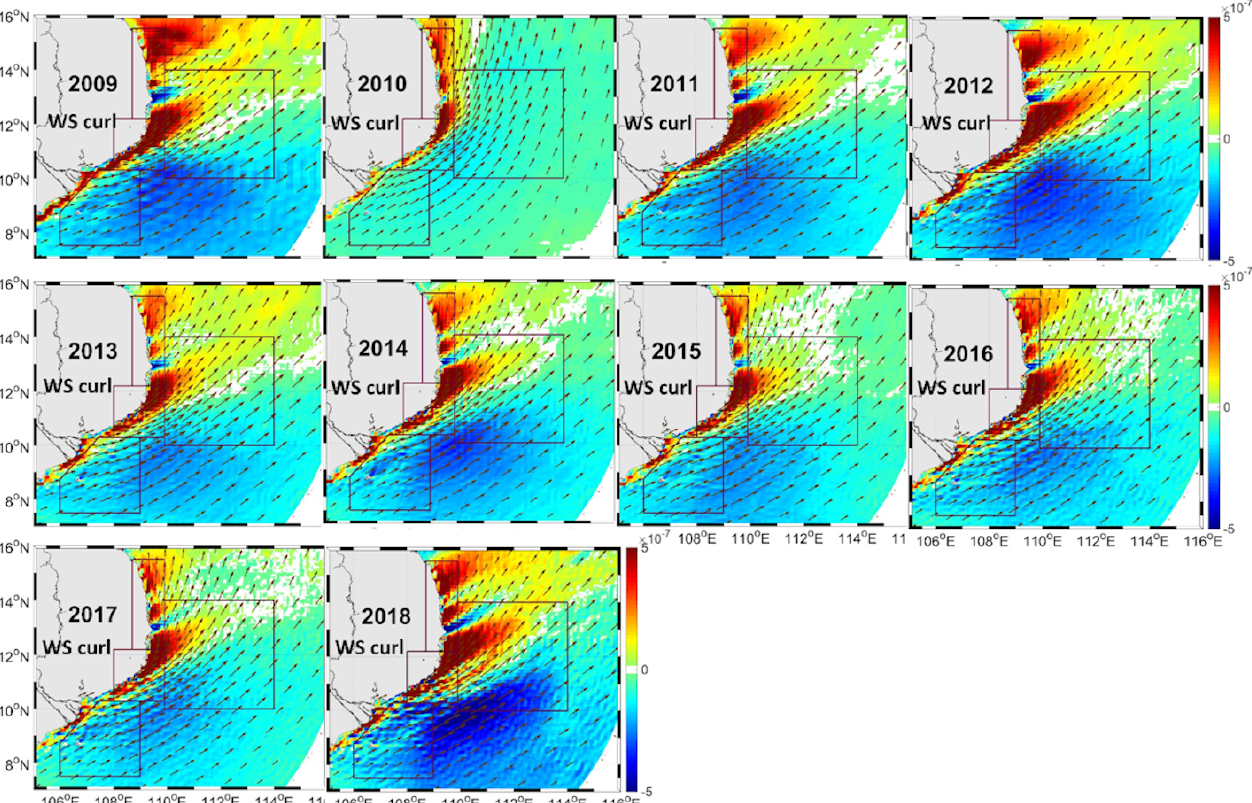
Figure 11. Maps of JJAS-averaged wind stress (arrows, Nm − 2 ) and wind stress curl (colors, Nm − 3 ) for each year of the simulation.